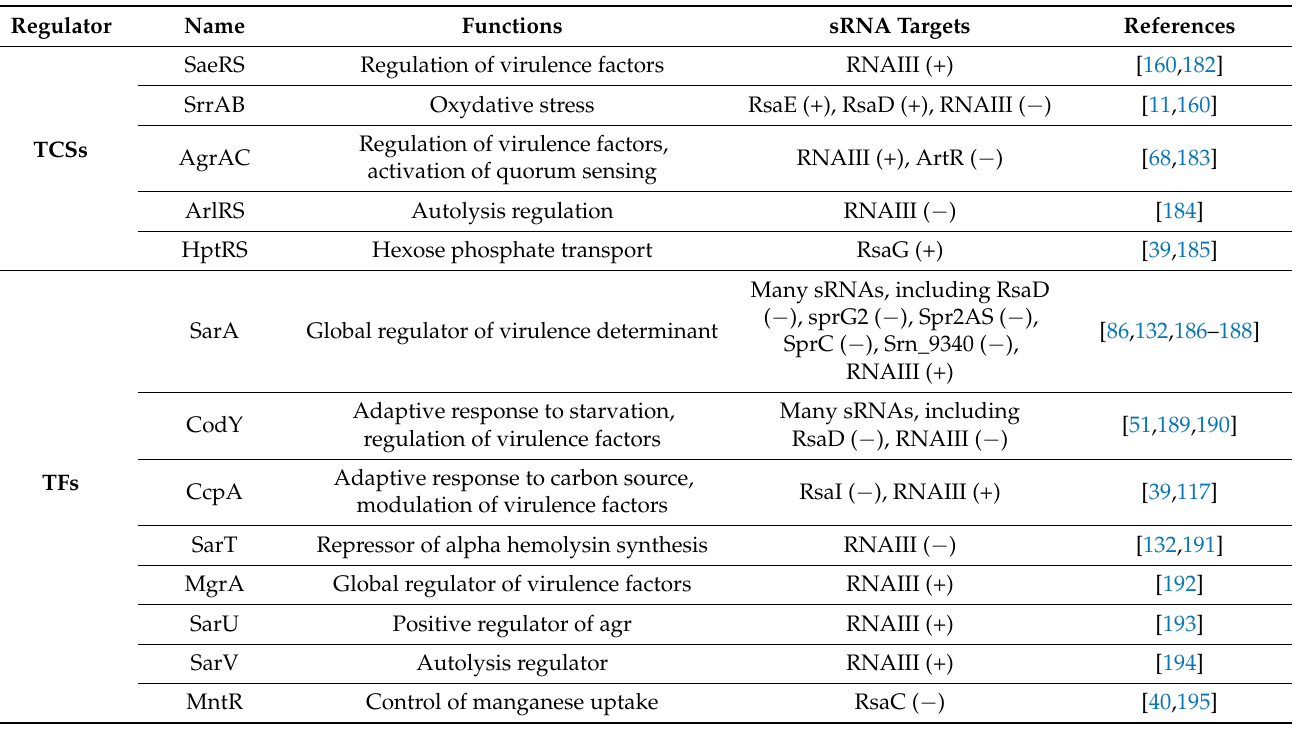
Table 4. Transcriptional regulation of sRNA expression by two-component systems and transcription factors. ( − ) indicates negative regulation and (+) indicates positive